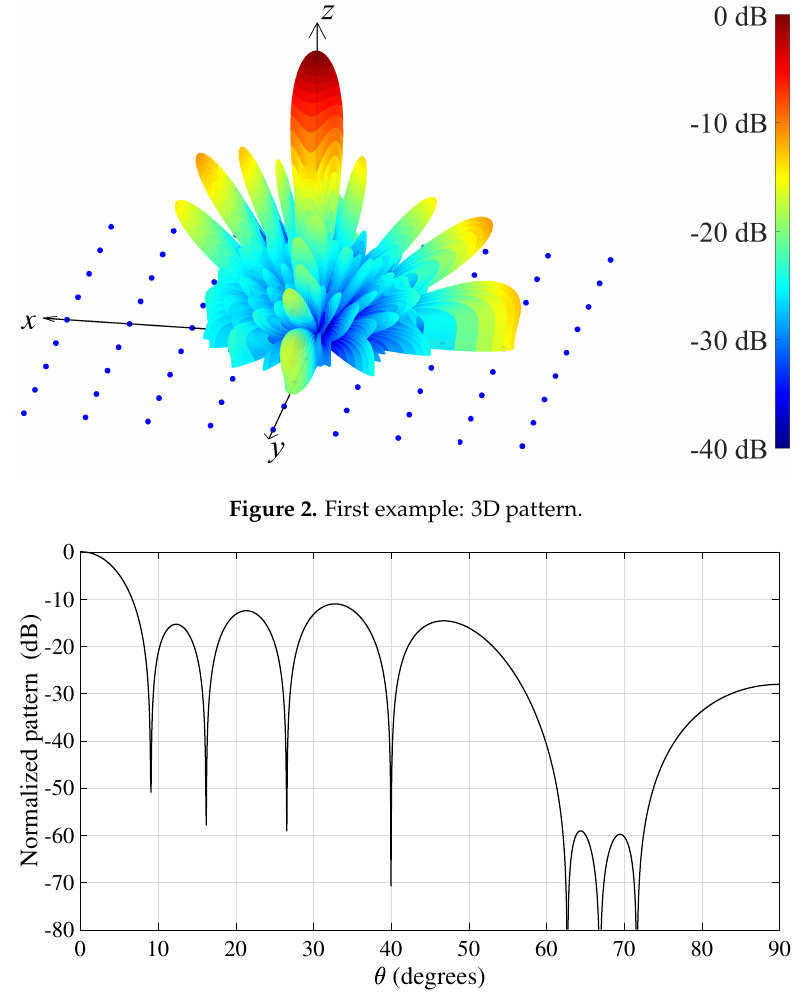
Figure 3. First example: 2D pattern cut at φ = 0 ◦